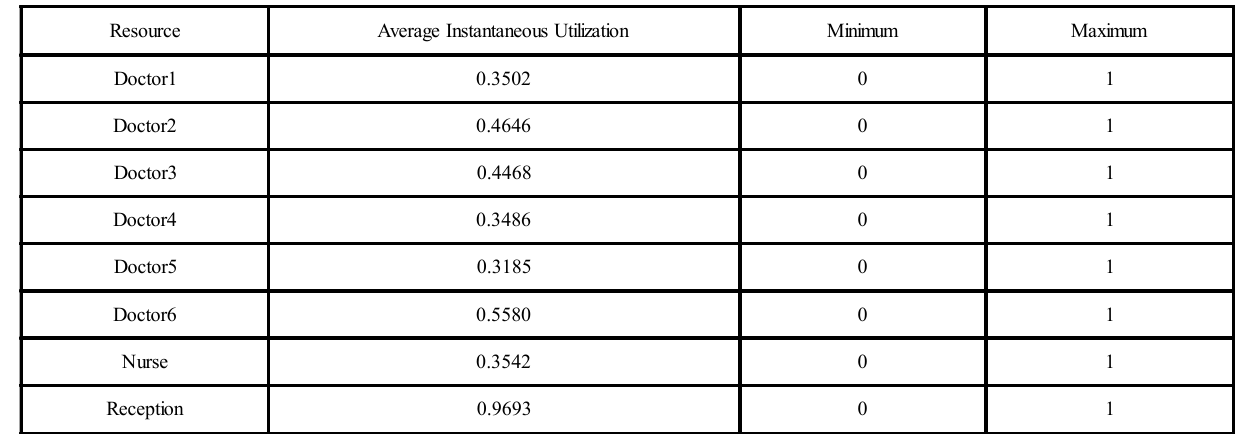
TABLE 6. RESOURCES‘ INSTANTANEOUS UTILIZATION AT THE OPD